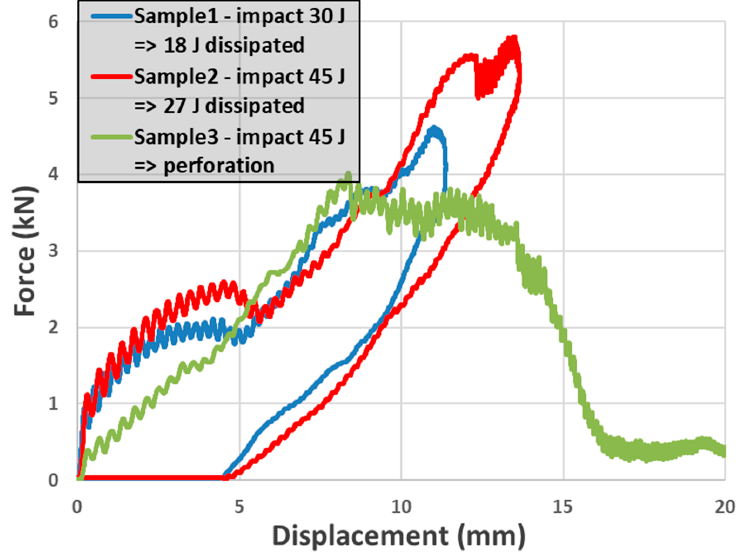
Figure 17. Force-displacement curves of impacts on the three samples and energy dissipated during the impact, obtained from the areas inside the curve.